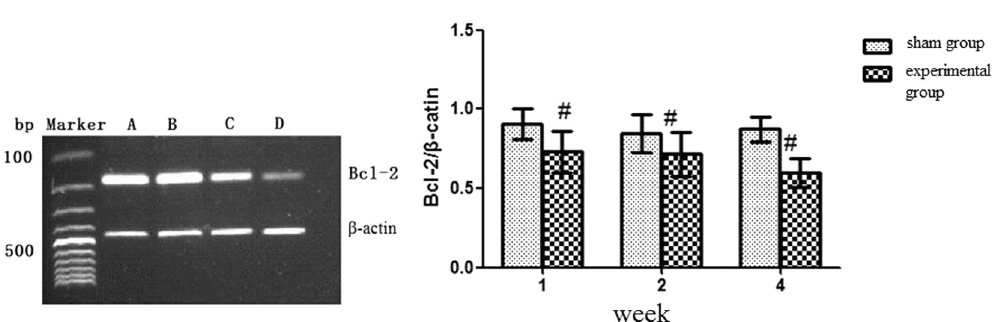
Figure 5. Bad mRNA expression in the rat CTEPH model. Note: ( A ) Sham group; ( B ) 1-week experimental subgroup; ( C ) 2-week experimental subgroup; ( D ) 4-week experimental subgroup. # P < 0.05 , compared to sham group within the same subgroup.